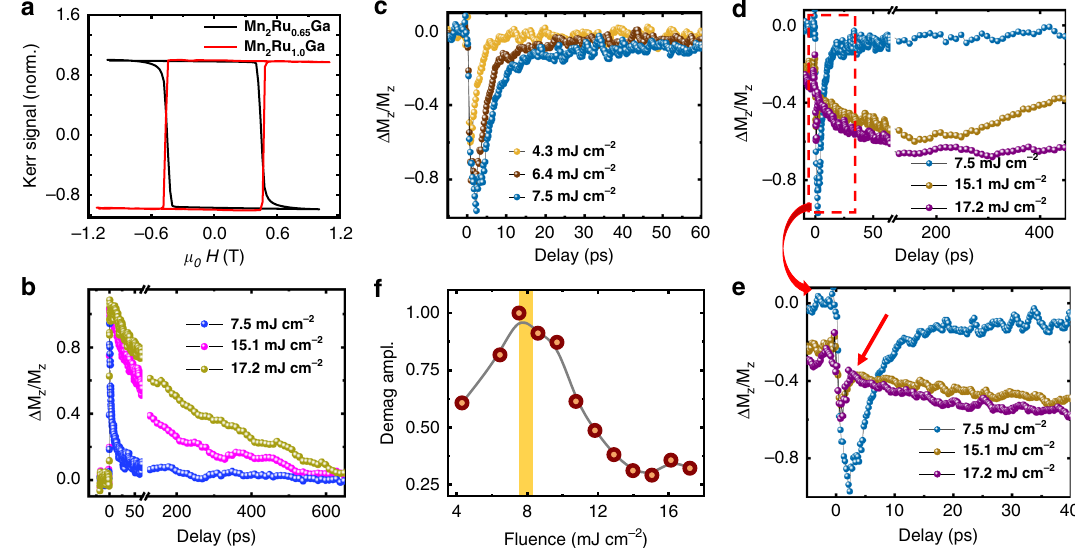
Fig. 4 Time resolved magnetization dynamics in Mn 2 Ru x Ga. a Hysteresis loops measured by MOKE in Mn 2 Ru 0.65 Ga and Mn 2 Ru 1.0 Ga, which have compensation temperature below and above RT respectively. b Transient Kerr signals of Mn 2 Ru 0.65 Ga for different pump fl uences. The variation of the Kerr signal is normalized to the total Kerr rotation at RT. c Transient Kerr signal of Mn 2 Ru 1.0 Ga for fl uences below the switching threshold; d similar data including fl uences above threshold; e A zoom of d in a shorter time window; the anomaly marked by the arrow is discussed in the text. f Variation of the demagnetization amplitude at zero delay for different pump fl uences. The yellow shaded region indicates the threshold fl uence for switching. The solid line is a guide to